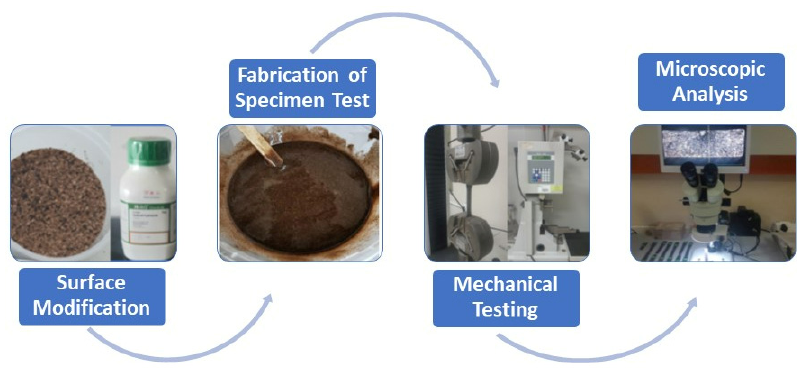
Figure 2. Research frameworks.